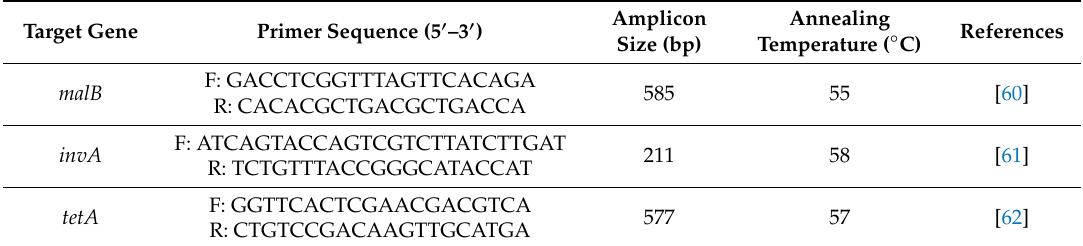
Table 3. List of primers used for detecting E. coli , Salmonella spp., and tetracycline-resistance gene. Target Gene Primer Sequence (5 (cid:48) –3 (cid:48)